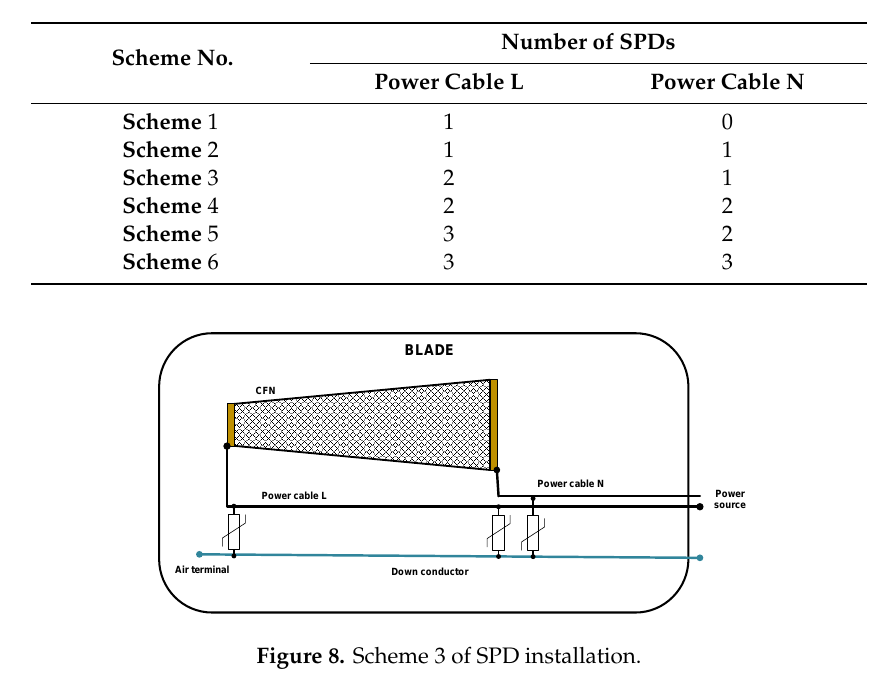
Figure 9. The voltage between the down-conductor and CFN is shown in Table 5.